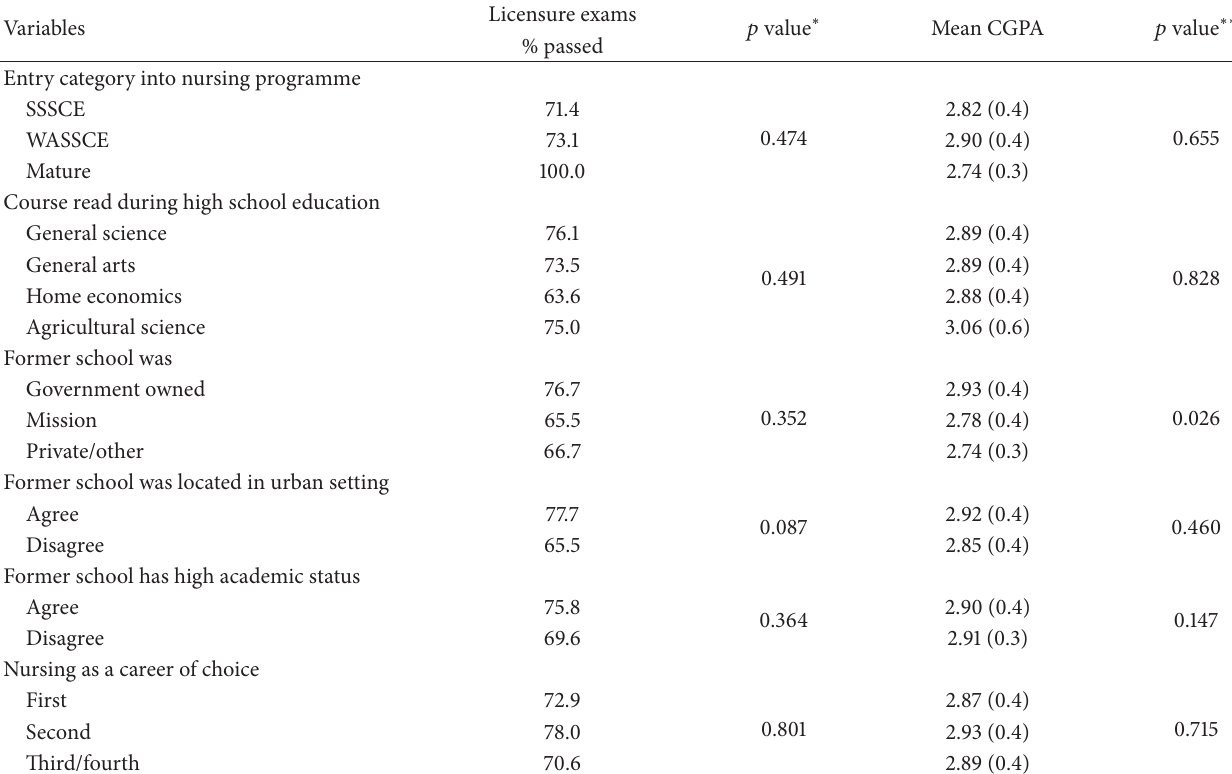
Table 4: Influence of previous education on students’ performance.